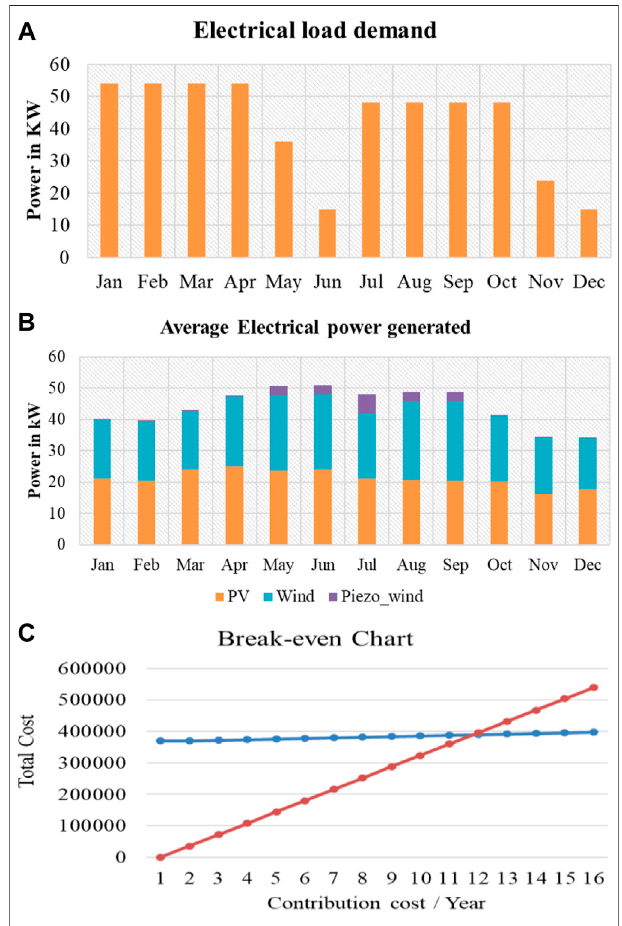
FIGURE 12 | (A) Average load requirement measured in the case study. (B) Average electrical power generated by the DC microgrid. (C) Break-even chart of the developed system.